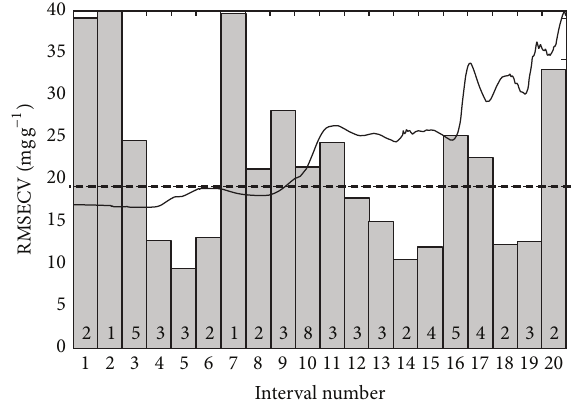
Figure 2: Spectral region selected by interval algorithms for deter- mination propranolol hydrochloride using FTNIR/PROBE. Num- bers inside the rectangles were the number of latent variables used in model